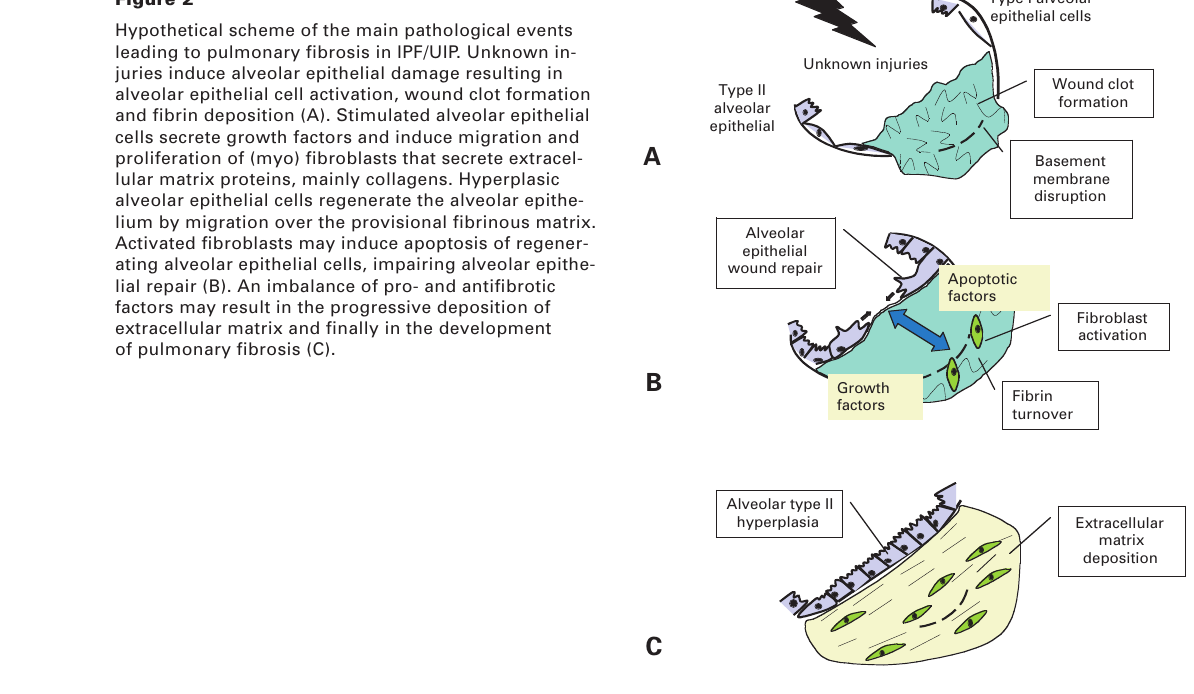
Hypothetical scheme of the main pathological events leading to pulmonary fibrosis in IPF/UIP. Unknown in- juries induce alveolar epithelial damage resulting in alveolar epithelial cell activation, wound clot formation and fibrin deposition (A). Stimulated alveolar epithelial cells secrete growth factors and induce migration and proliferation of (myo) fibroblasts that secrete extracel- lular matrix proteins, mainly collagens. Hyperplasic alveolar epithelial cells regenerate the alveolar epithe- lium by migration over the provisional fibrinous matrix. Activated fibroblasts may induce apoptosis of regener- ating alveolar epithelial cells, impairing alveolar epithe- lial repair (B). An imbalance of pro- and antifibrotic factors may result in the progressive deposition of extracellular matrix and finally in the development of pulmonary fibrosis